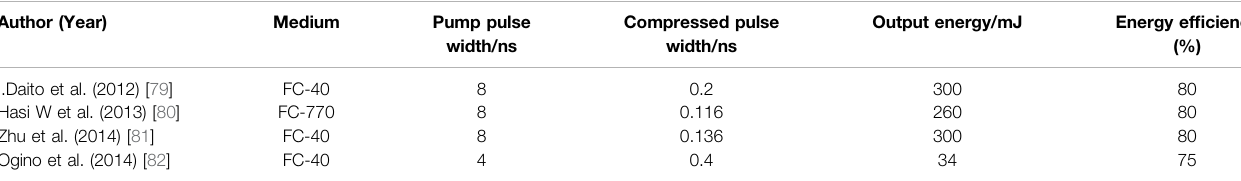
TABLE 2 | Typical experiments of compact two-cell